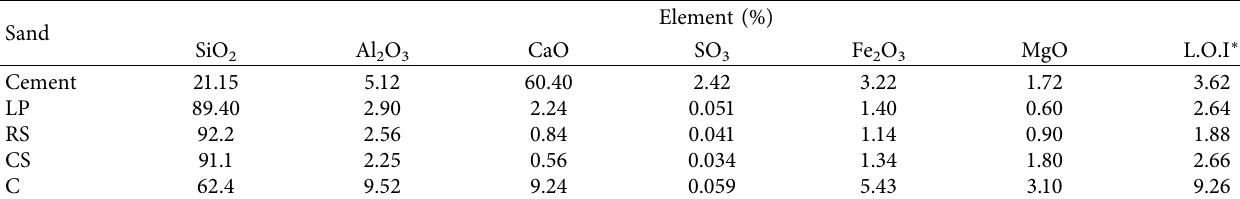
Figure 1: Pictures of sands used in current study: (a) LP, (b) RS, (c) CS, (d) C, and (e) NC. Table 2: Chemical analysis of the cement and fne aggregates.